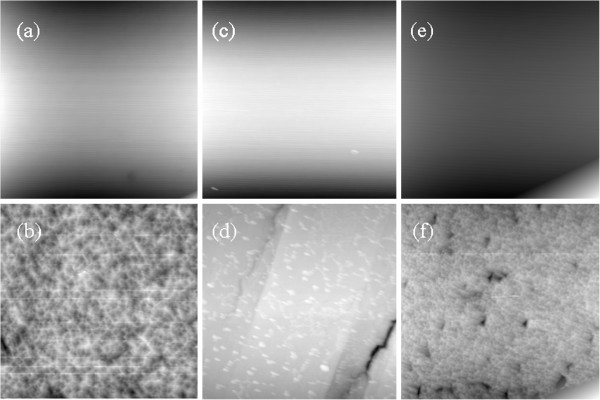
AFM images (10 × 10 μm2).The as-received (a, c, e) and etched (b, d, f) (001) (a, b), (011) (c, d), and (111) (e, f) STO substrates.